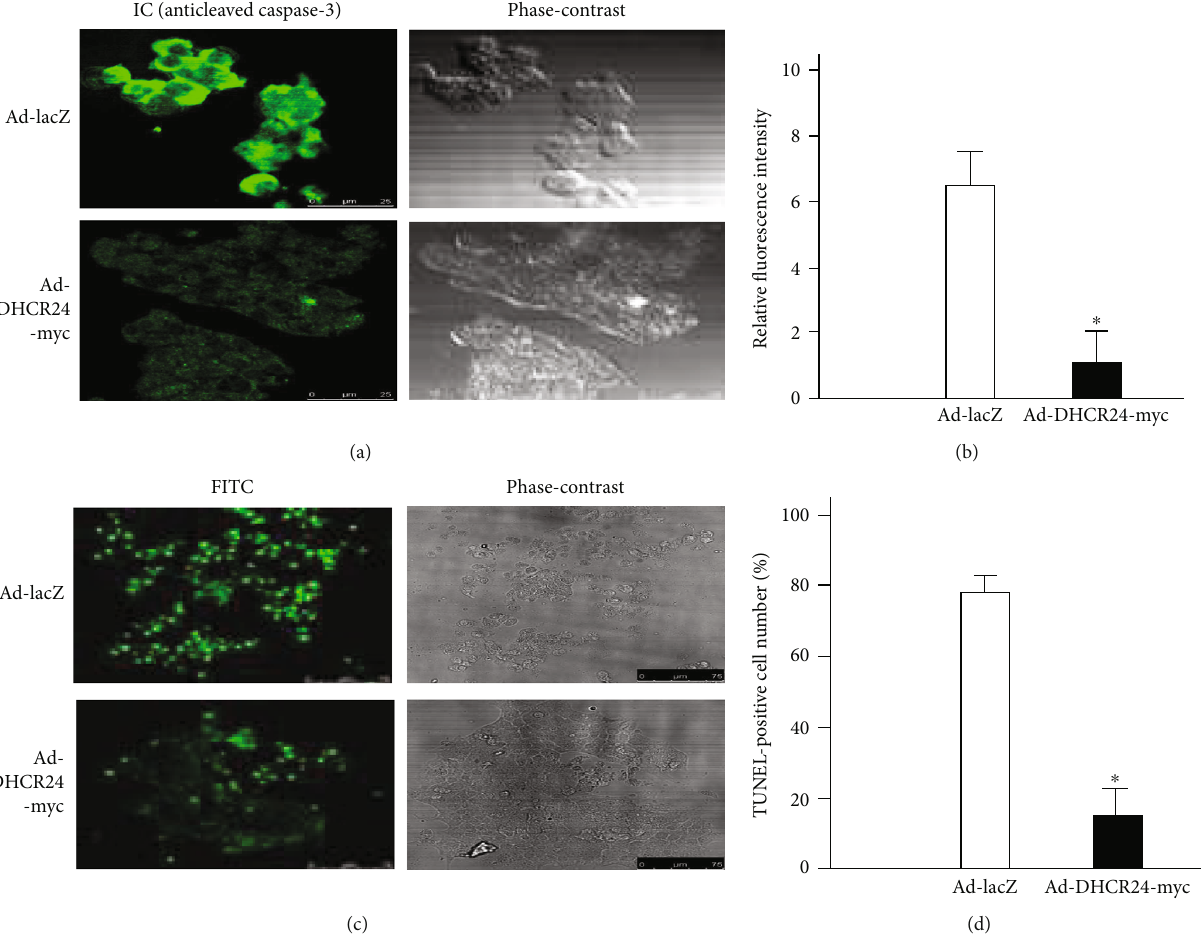
Figure 2: Apoptosis of MIN6 cells induced by TM is inhibited by overexpression of DHCR24. (a) A representative fl uorescent image of cleaved caspase-3 (green) was obtained by IC analysis 24h after TM exposure. Scale bar, 50 μ m. (b) The relative fl uorescence intensity of cleaved caspase-3 was analyzed with ImageJ software. Mean ± S : D : ( n = 3 ); ∗ p < 0 : 05 vs. Ad-LacZ. (c) The apoptosis of MIN6 cells was analyzed by TUNEL 24 h after TM treatment. The green fl uorescent signal represents TUNEL-positive cells. Scale bar, 100 μ m. (d) The TUNEL-positive cell number was calculated as percentage of TUNEL-positive cell numbers to adherent cells in the same fi eld. Mean ± S : D : ( n = 3 ); ∗ p < 0 : 05 vs.